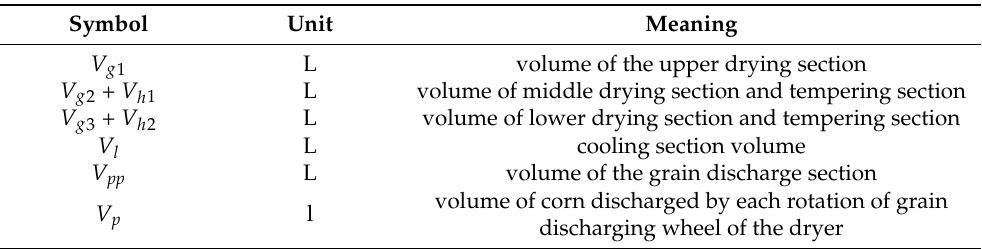
Table 10. Formulas (11)–(14) symbols and